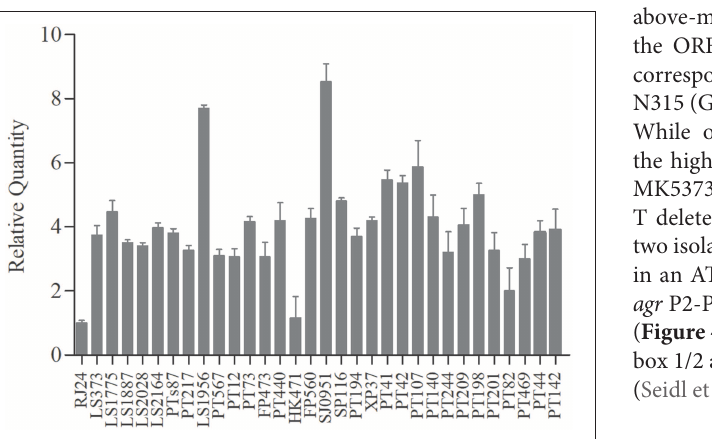
FIGURE 2 | The transcriptional levels of tst gene in 32 chosen S. aureus strains representative. No obvious variations in the expression levels of tst gene among most of the strains, except two MRSA strains (L-RJ24 and L-HK471) with higher and two MSSA strains (H-LS1956 and H-SJ0951) with lower tst mRNA abundances. Data are expressed as the means ± standard deviation (SD). The experiment was independently repeated three